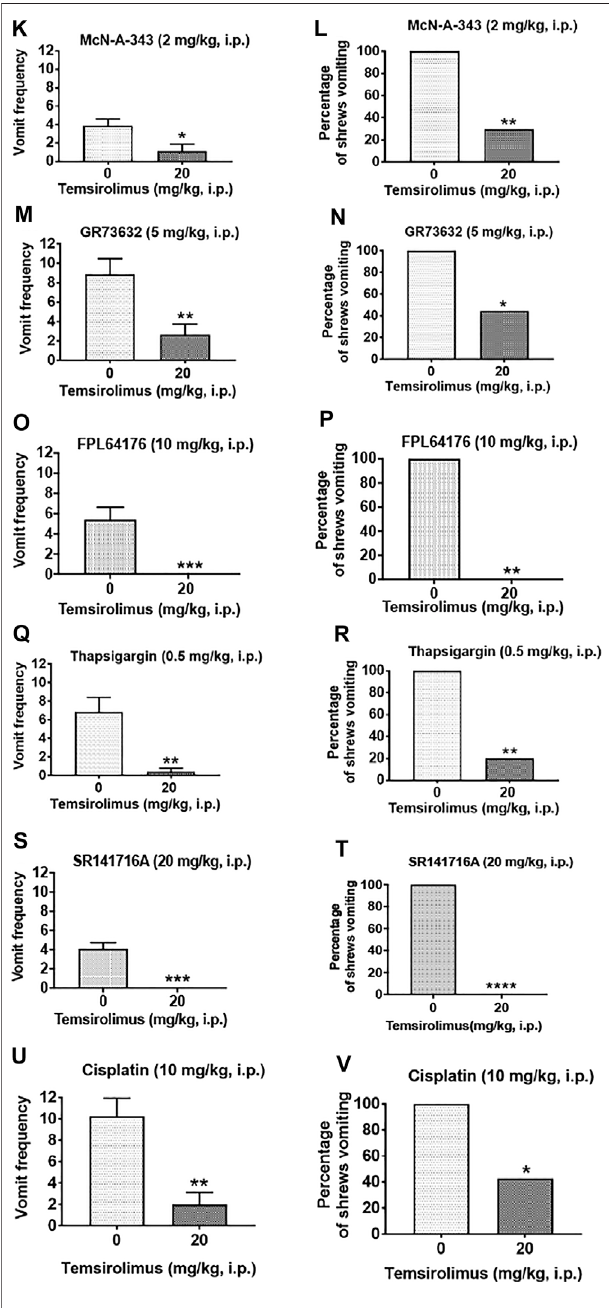
the AP ( p = 0.0001 versus vehicle), 58.3 ± 6.9 in NTS ( p = 0.0002 vehicle), and 6.2 ± 1.2 in DMNX ( p = 0.2 versus vehicle) ( Figure 5G ). When 20 mg/kg temsirolimus was injected, the mean numbers of the c-fos-immunoreactive cell nuclei did not increase signi fi cantly, 19.3 ± 1.9 in the AP ( p = 0.53 versus vehicle), 28.5 ± 3.3 in NTS ( p = 0.14 versus vehicle), and 3.3 ± 0.9 in DMNX ( p = 0.99 versus vehicle) ( Figure 5G